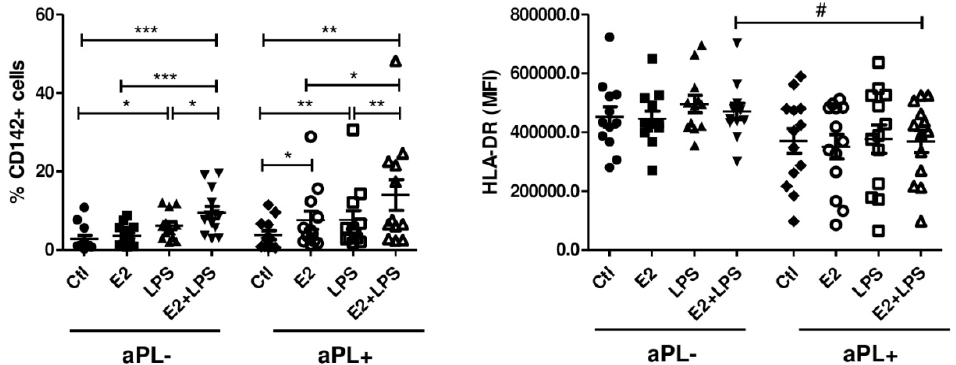
Figure 1. Percentage of CD142 + monocytes and HLA-DR MFI on monocytes from aPL- and aPL + groups. PBMCs were cultured for 24 h in the absence (Ctl) and presence of E2, LPS, and E2 + LPS, and analysed by flow cytometry. One-way ANOVA was used to assess statistical significance. Due to the missing data, CD142 expression on monocytes was assessed using the Wilcoxon signed-rank test. The results are shown as mean ± SEM. * ,# p < 0.05, ** p < 0.01, *** p < 0.001.